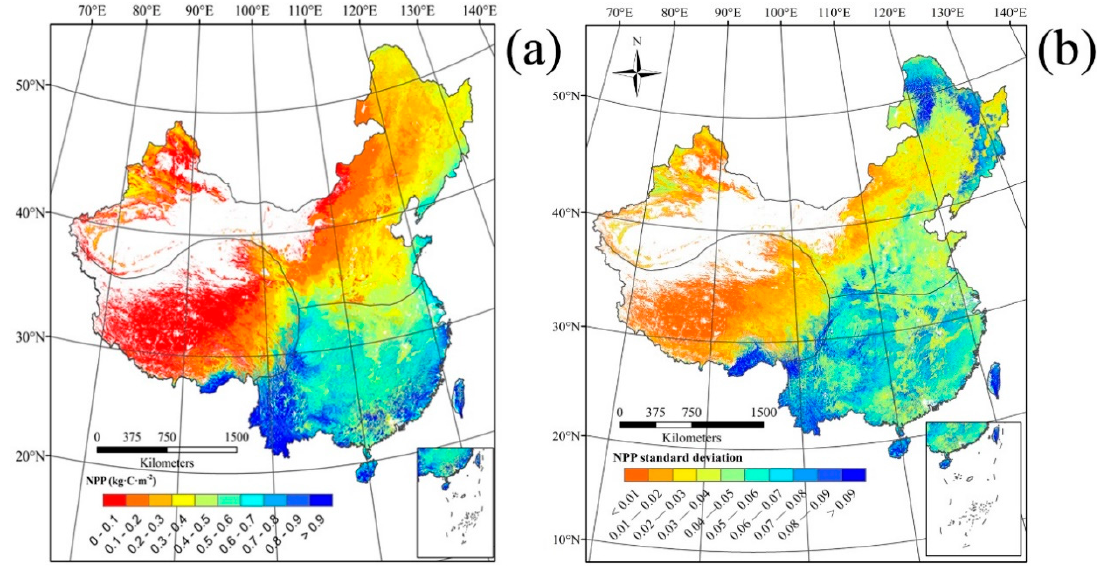
Figure 2. Spatial distribution of mean Net Primary Productivity (NPP) ( a ) and standard deviation ( b ) in China between 2001–2014.